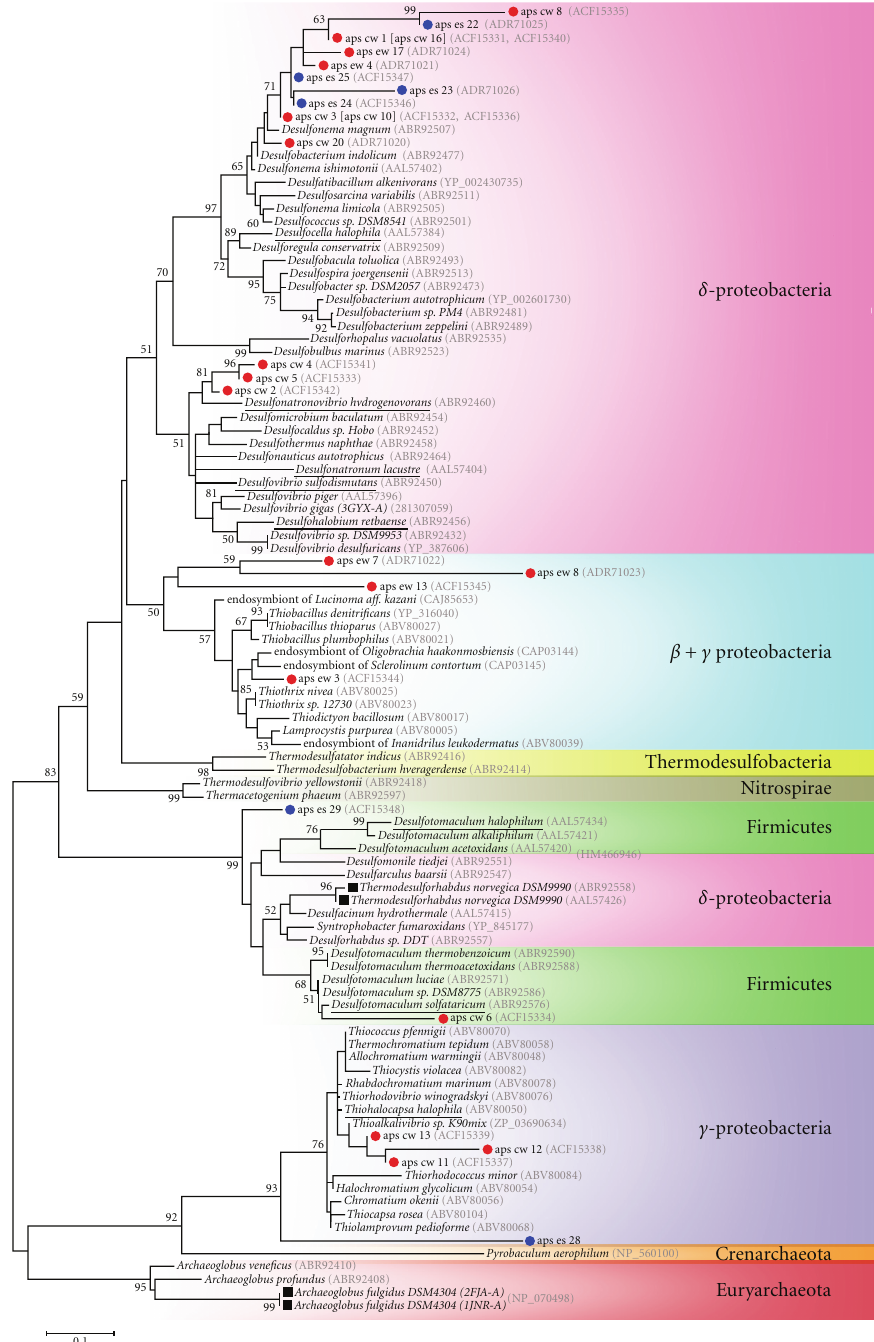
Figure 5: The phylogenetic tree is showing the relationship of AprA sequences from environmental samples and nonaxenic cultures from Tirez sediments and aprA sequences of characterized SRP and SOP (supplementary material, Table S1). The blue circle identifies the summer phylotypes and red circle is for the winter phylotypes. Halophilic known species are underlined. Same species from di ff erent strain with interesting amino acid changes from basic (Lys and K) to polar (Gln, Q and Asn, N) are marked with grey squares (see supplementary Figure S2). The number of redundant phylotypes defined by an identity of 100% is indicated in parenthesis after the accession number. The scale bar represents 0 ± 1 substitutions per aa position. Percentages ≥ 50% of bootstrap are indicated near the nodes. See Section 2 to observe details of the phylogenetic reconstruction done for this